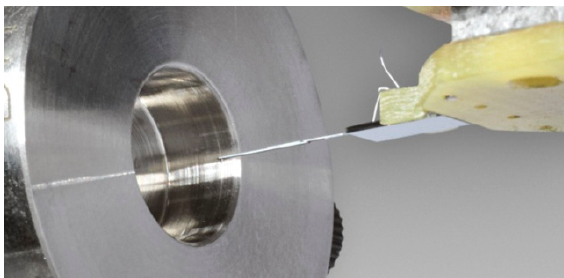
22 of 30 . Figure 36. FFT spectrum of the profile measured on the sinusoidal artefact (see Figure 35). 4. Experimental Results Up to now, the main application of these slender microprobes has been for fast roughness and form measurements inside micro-nozzles, like critical nozzles for gas flow measurements and diesel injection nozzles. Within the EU MicroProbes project [8], these microprobes have been attached to manufacturing machines and a new application has been added including the measurement of mechanical parameters of surfaces. 4.1. Measurement of Roughness and Form Deviation inside Micro-Nozzles The microprobes with a total length of 1.25 mm were specifically designed for the measurement of micro-nozzles. The slender cantilever has a width of 30 µm and also a small total height of < 50 µm (cantilever height plus tip height). Thus, it is able to measure roughness and form in micro-nozzles with diameters down to approximately 70 µm. Measurements on gas and injection nozzles are presented as examples. 4.1.1. Critical Flow Venturi Nozzles (Sonic Nozzles) for Gas Flow Measurements Due to their long-term accuracy and excellent repeatability, sonic nozzles have been used in a number of industrial and scientific applications for gas and fluid flow measurements, such as calibration standards. In the case of sonic nozzles, the flow rate remains constant over the nozzle when the differential pressure exceeds a certain minimum value. The smaller the flow rate, the smaller the diameter of the corresponding nozzle must be. With smaller nozzles, however, the topography of the inner surface has an increased influence on the flow behavior and the flow rate. For nozzles with a diameter below 1.5 mm, significant deviations from the specified ideal shape and surface may occur. These deviations can turn out to be extremely disturbing in practice and we do not yet understand why they occur in connection with the inner topography. Measuring the inner surface of such small nozzles with conventional tactile and optical measuring instruments is, however, very difficult.